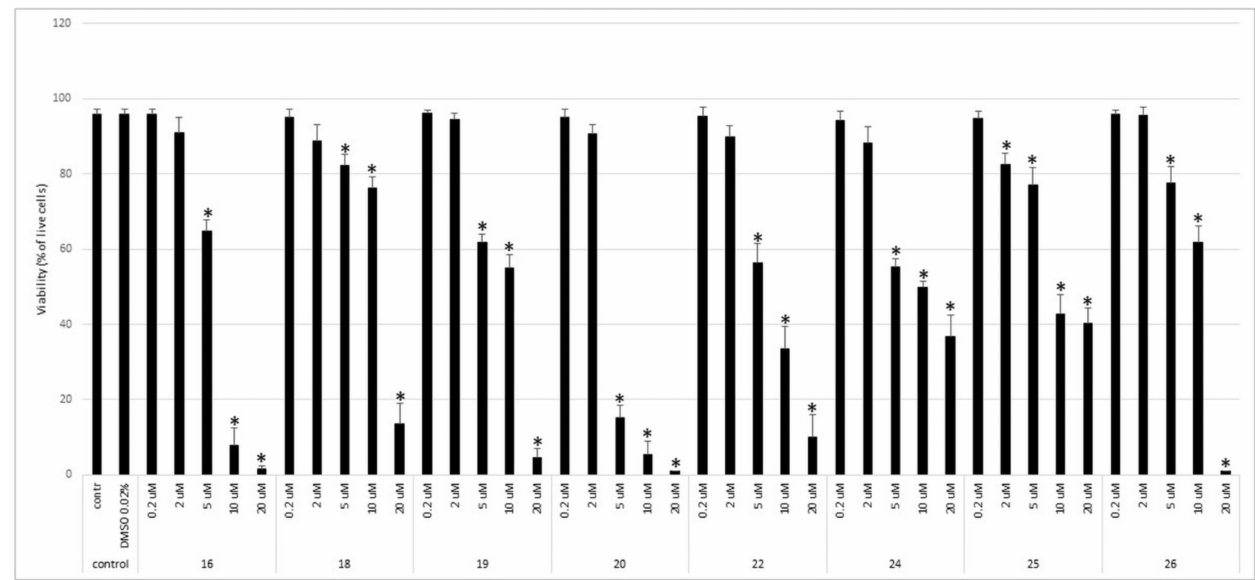
Figure 3. The influence of cationic 16 , 18 , 20 , 22 , 24, and 26 bola dendrimers and their neutral precursors 19 and 25 on CGC viability. CGC were treated with 0.2, 2, 5, 10, and 20 µ M of 16 – 26 for 30 min in Locke 25 medium. Viable cells were counted after 24 h as described in Material and Methods. The results are presented as means ± SD from six repetition performed using independently prepared cultures. * The effects of tested compounds which are significantly different from the 0.2% DMSO (solvent of